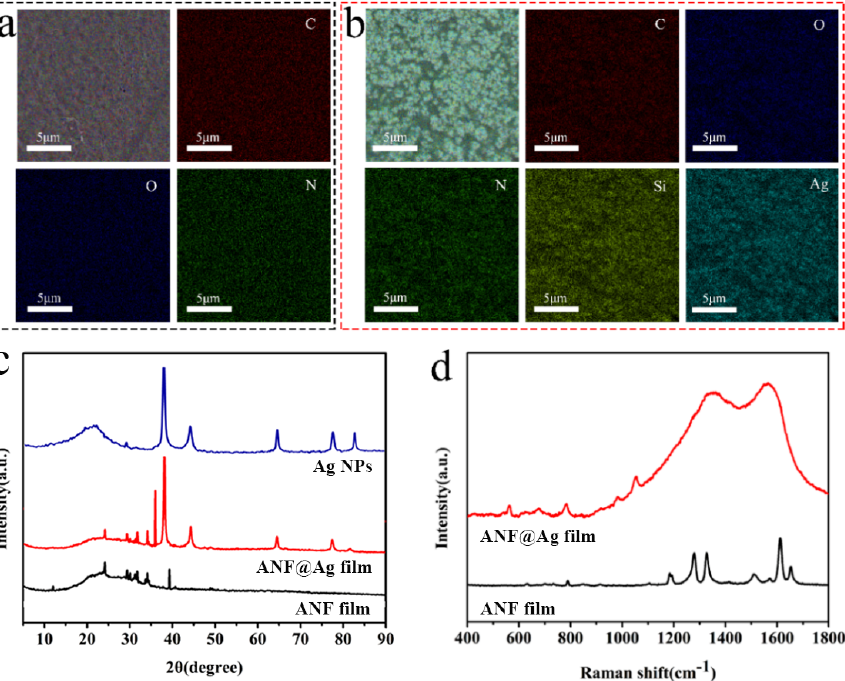
Figure 5. EDS mapping of the ( a ) ANF film and ( b ) ANF@Ag nanocomposite film; ( c ) XRD of the Ag NPs, ANF film and ANF@Ag nanocomposite film; and ( d ) Raman spectra of the ANF film and